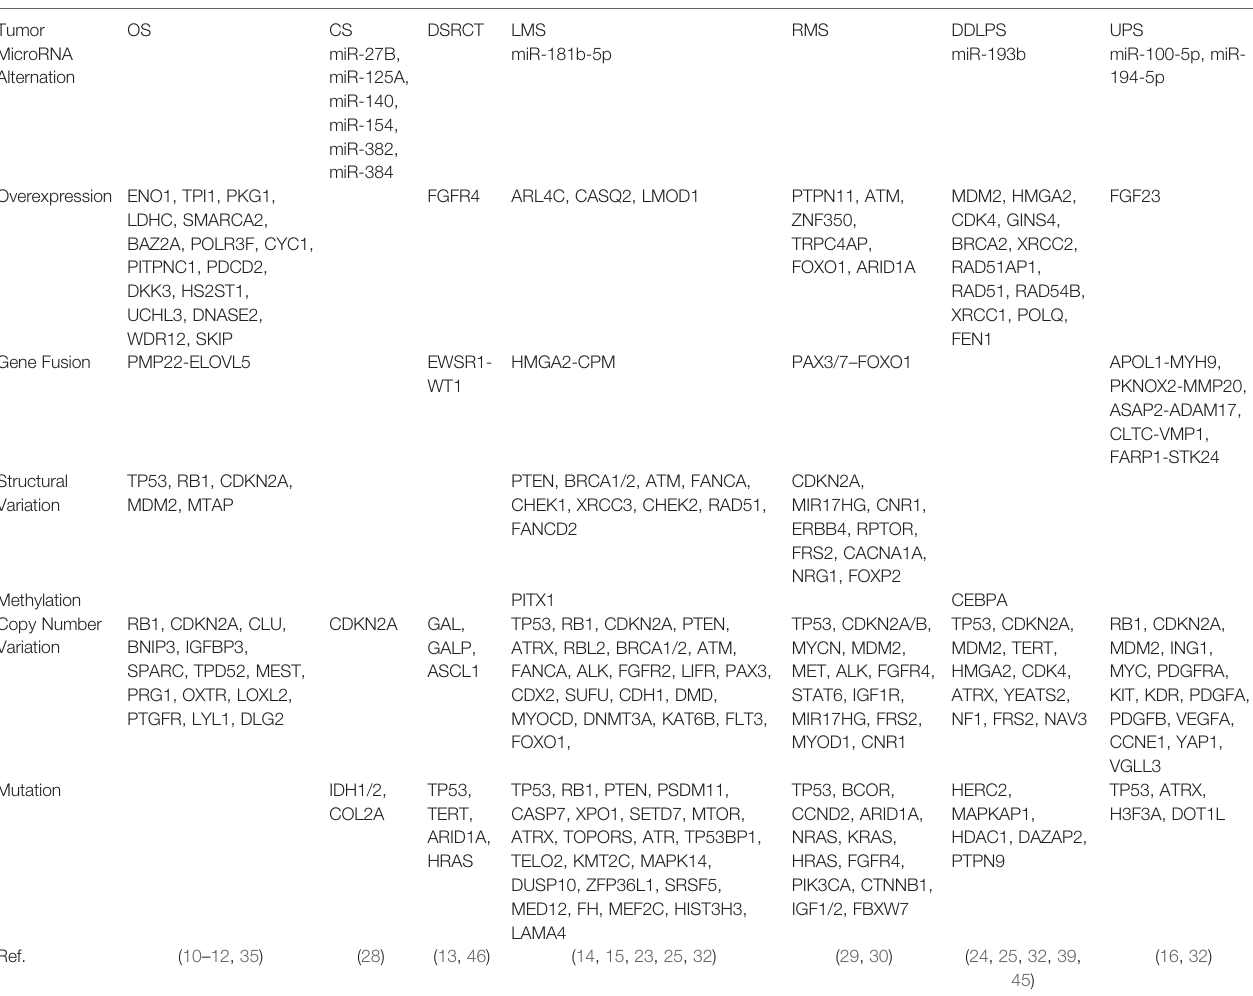
TABLE 2 | Alternations of omics found in research of major sarcoma